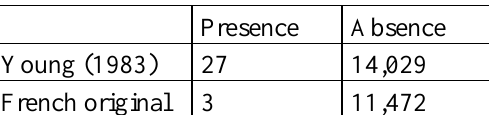
Table 3. Presence and absence of camarade in La Fontaine’s fables and their adaptation into SC by R.